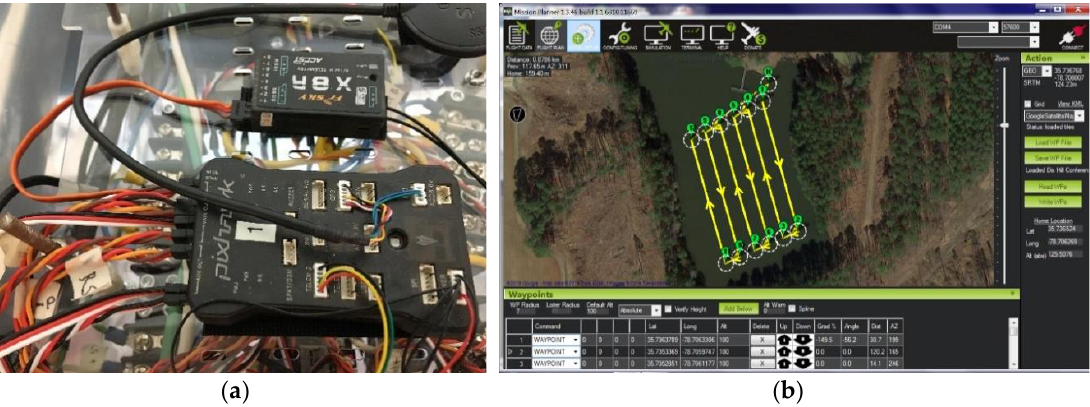
Figure 9. Features utilized for autonomous vehicle control: ( a ) Pixhawk autopilot module as installed within a prototype (receivers and other electronics in background); ( b ) Mission Planner interface showing generation of transects.